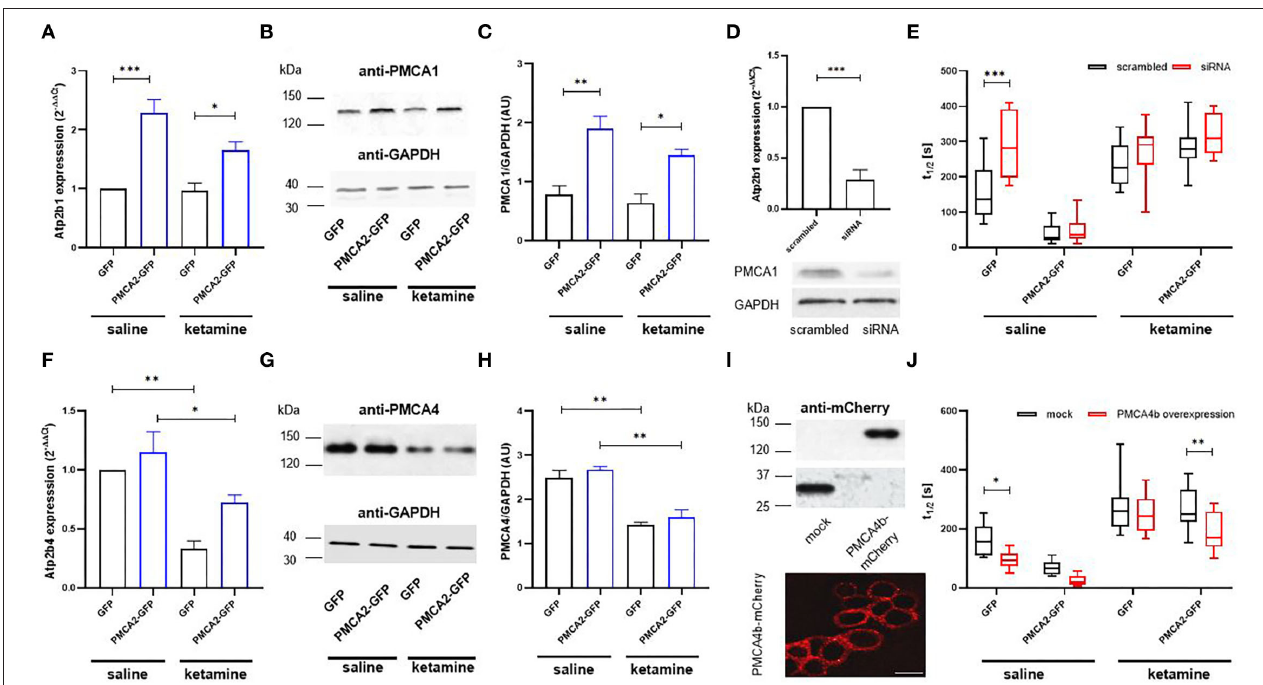
FIGURE 3 | The contribution of PMCA isoforms to the rate of Ca 2 + clearance following 30mM KCl treatment in the presence or absence of ketamine. (A) The expression of Atp2b1 in GFP- or PMCA2b-GFP expressing cells was qualified using real-time PCR. The raw data were normalized to endogenous Gapdh expression and were calculated based on the 2 − 11 Ct method to obtain relative fold change. The expression level in GFP control treated with saline was taken as 1, n = 4. (B) PMCA1 protein level was determined with the Western blot. GAPDH was used as a loading control. The representative images are shown. (C) Quantification of PMCA1 protein level following normalization to endogenous Gapdh level, n = 3. AU, arbitrary units. (D) The efficiency of Atp2b1 silencing with siRNA evaluated using real-time PCR and confirmed at the protein level with the Western blot. The reduction in mRNA level was quantified using the 2 − 11 Ct method, and the expression in scrambled-treated cells was taken as 1, n = 3. (E) Halftime of signal decay (t 1 / 2 ) of individual tracings recorded from scrambled or PMCA1 siRNA-treated cells, presented as interleaved box graph centered at the mean. (F) The expression of Atp2b4 in GFP- or PMCA2b-GFP expressing cells, n = 3. (G) Immunoreactivity of PMCA4 determined with the Western blot. (H) Quantification of PMCA4 protein level following normalization to endogenous Gapdh level, n = 3. AU, arbitrary units. (I) Over-expression of PMCA4b-mCherry protein and the targeting of the fusion protein to the plasma membrane visualized by immunocytochemistry. Scale bar 20 µ m. (J) Halftime of signal decay (t 1 / 2 ) of individual tracings recorded from mCherry- or PMCA4b-mCherry-positive cells, presented as interleaved box graph centered at the mean. Here, the mock-transfected control was cells double transfected with GFP and mCherry. * P < 0.05, ** P < 0.01, *** P <